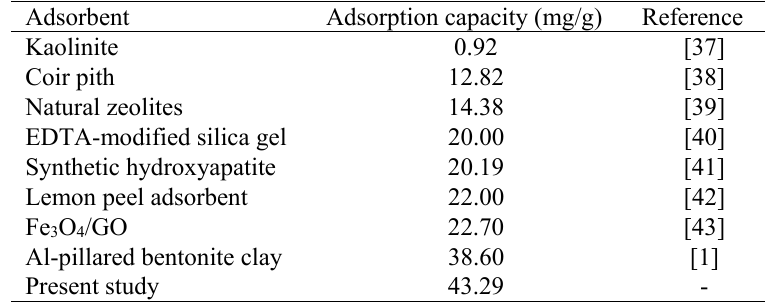
Table 3. Comparison of adsorption capacity (mg/g) of different adsorbents for removal of Co(II) ions.